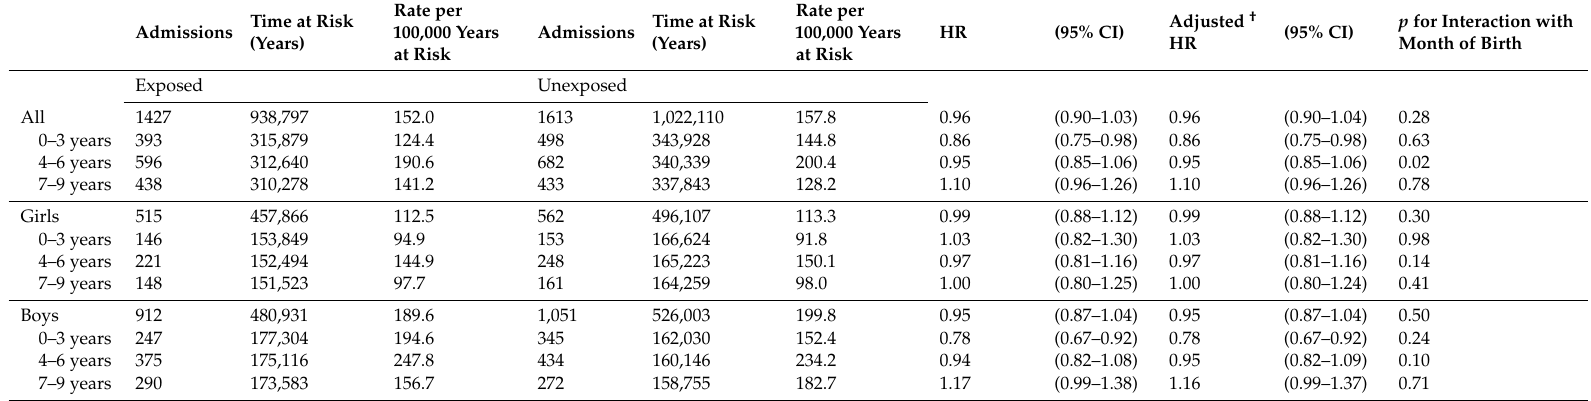
Table 1. Incidence, years at risk, rate, and hazard ratio (HR) of childhood asthma among those prenatally exposed to the margarine fortification with vitamin D policy, compared to those